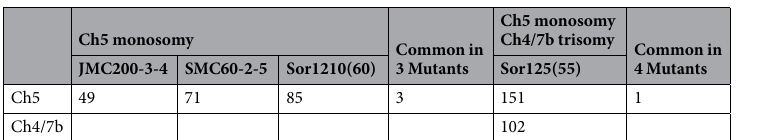
Table 5. Number of genes expressed at the disomic level on the monosomic Ch5 or the trisomic Ch4/7b in mutants JMC200-3-4, SMC60-2-5, Sor1210(60), and Sor125(55) and number of genes in common, as